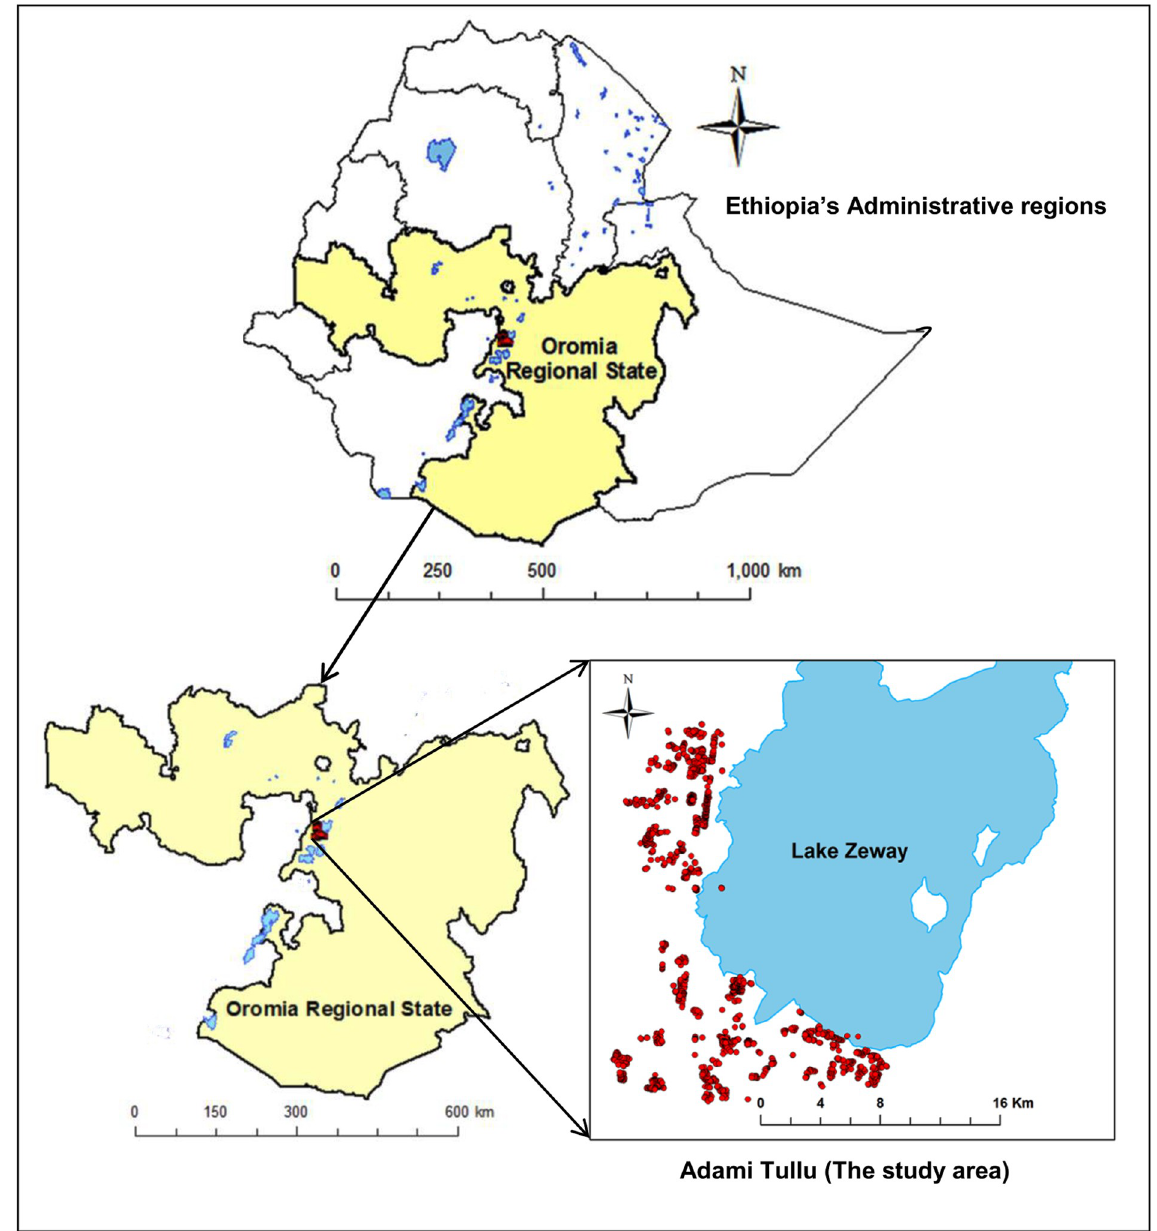
Fig 1. Map of the location of the study households in the Adami Tullu District in south-central Ethiopia.